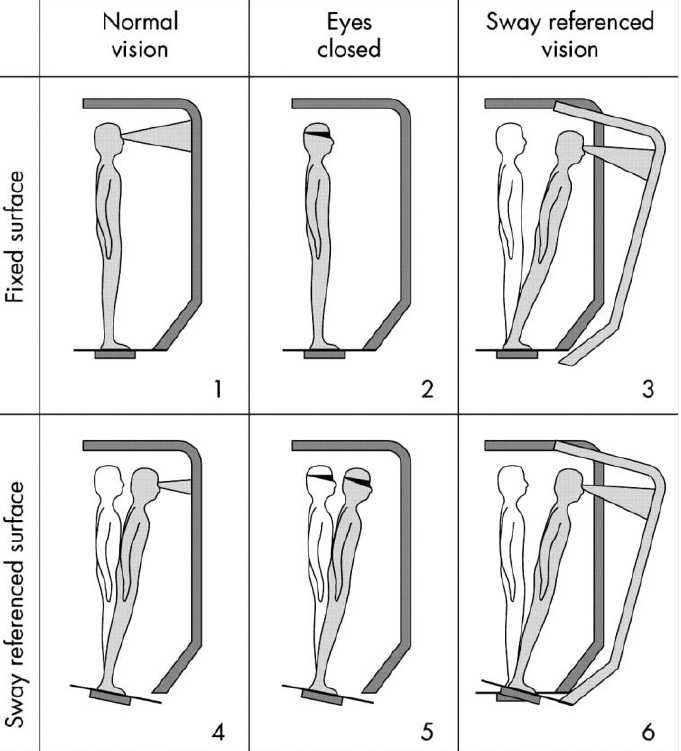
Figure 1. The 6 conditions of the Sensory Organization Test (SOT) constitute the following: ( 1 ) eyes open, stable support; ( 2 ) eyes closed, stable support; ( 3 ) sway-referenced vision, stable support; ( 4 ) eyes open, sway-referenced support; ( 5 ) eyes closed, sway-referenced support; and ( 6 ) eyes open, sway-referenced vision, and sway-referenced support [6].